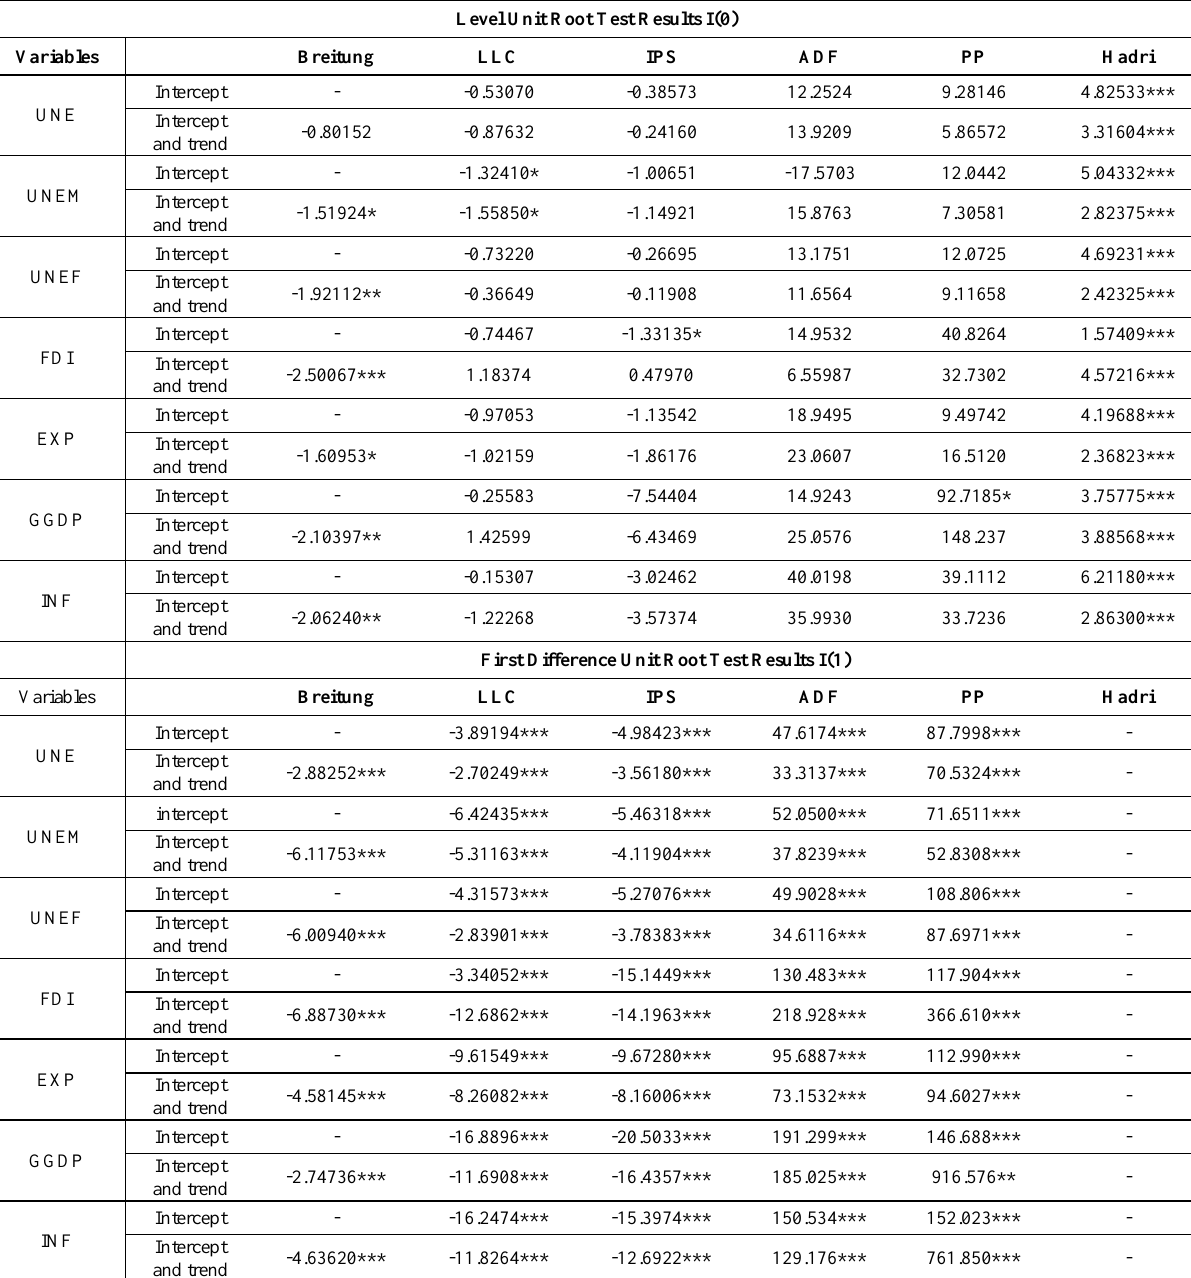
Table 3. Panel Data Unite Root